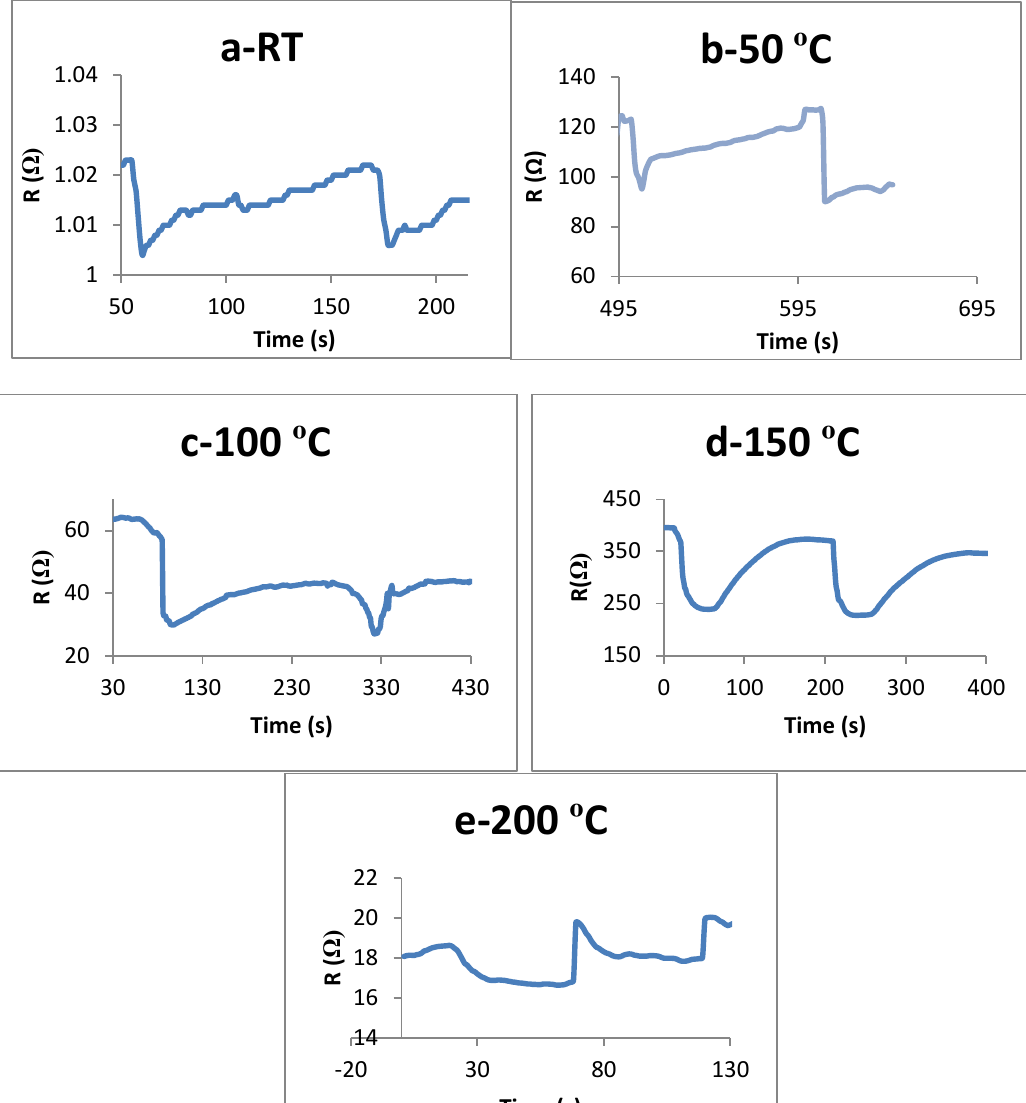
Fig.4: Resistance-time variation of F-MWCNTs sensor time at a-RT, b-50 c-100 d-150 and e-200 testing temperature upon exposure to NO 2